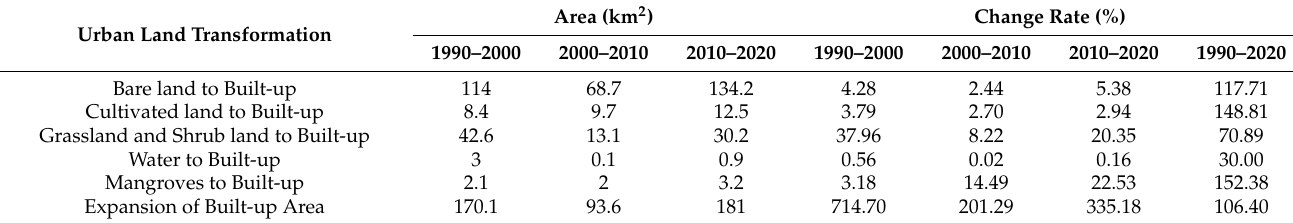
Figure 6. Spatial pattern of land transformation in Karachi during the periods of ( a ) 1990–2000, ( b ) 2000–2010, and ( c ) 2010–2020. Table 5. Land transformation from other LULC classes to built-up area during the periods of 1990–2000, 2000–2010, and